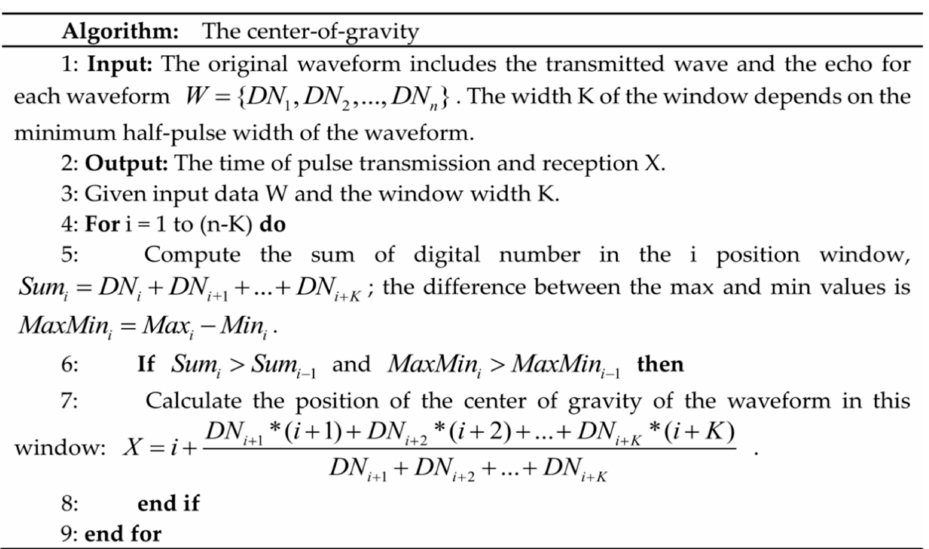
Figure 3. Schematic diagram of the echo wave pattern at signal saturation for ( a ) the transmitted pulse and ( b ) the received pulse. The solid red line is a Gaussian-fitted waveform, the dotted red line is the time of pulse reception obtained by the Gaussian fitting method, the solid black line is a broadened pulse resulting from signal saturation, and the time corresponding to the dotted black line is the pulse reception time obtained by the center-of-gravity (COG) method.